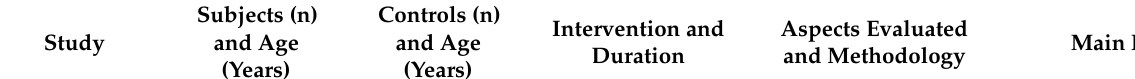
Table 4. Peripheral excitability studies evaluating motor-unit discharge rates and synchronization following RT in older